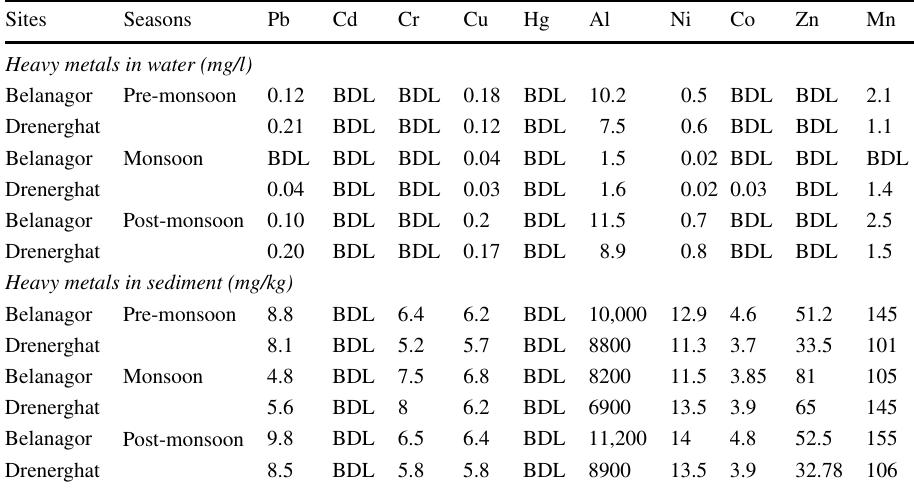
Sites Heavy metals in water